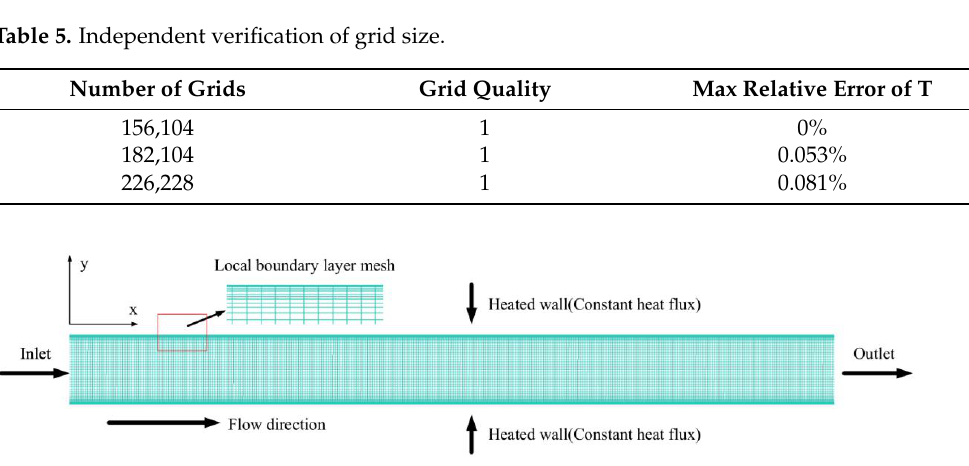
Figure 2. Grid diagram of computing domain.